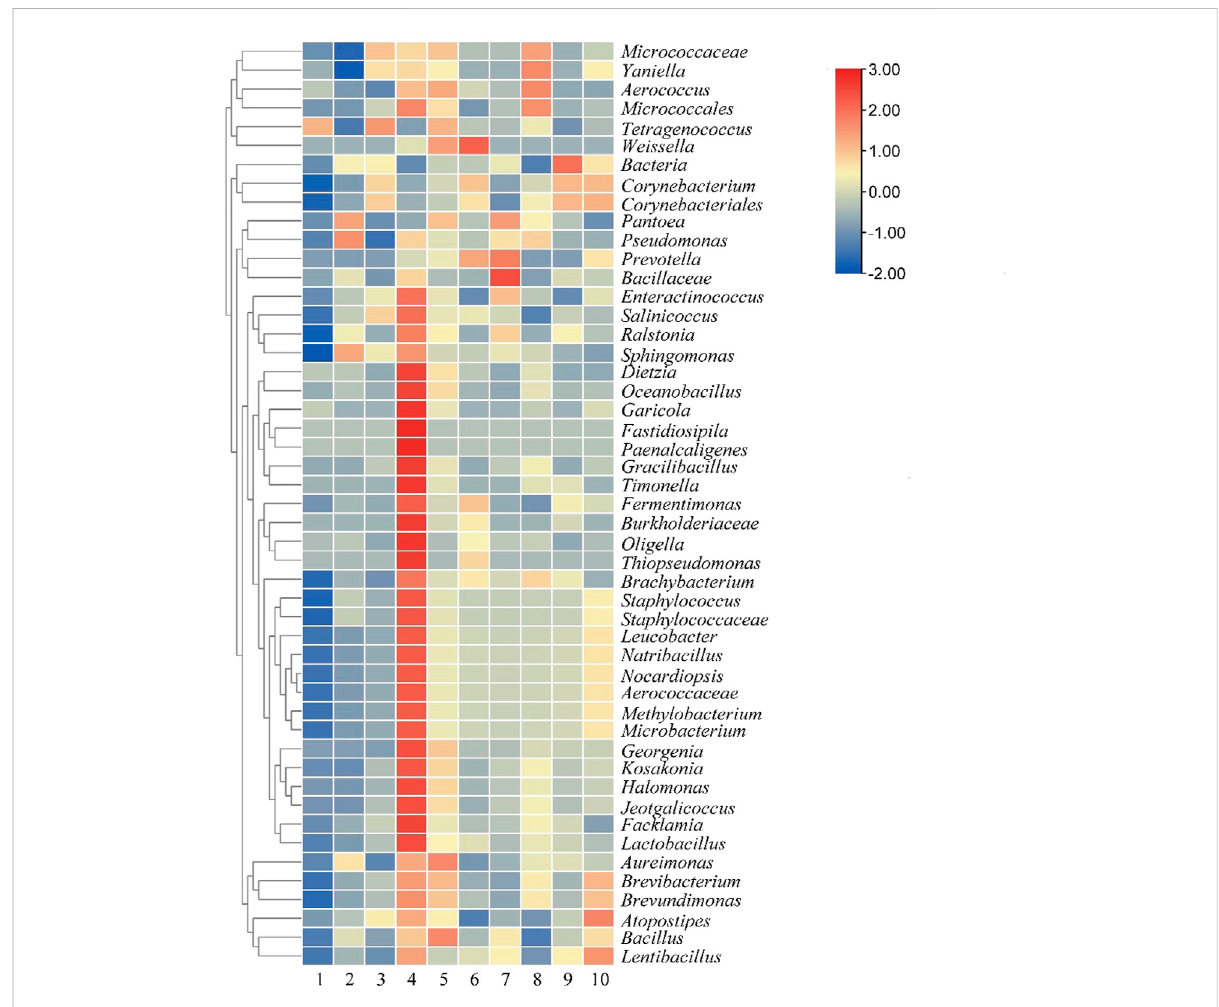
FIGURE 7 Microbial community ofcigar tobacco leaves atgenus level. Note: 1 to 5 wererespectively added water and fermentedfor 0d, 2 d,4 d, 6d, 8 d, 6-10 were followed by medium fermentation for 0 d, 2 d, 4 d, 6 d, 8 d.